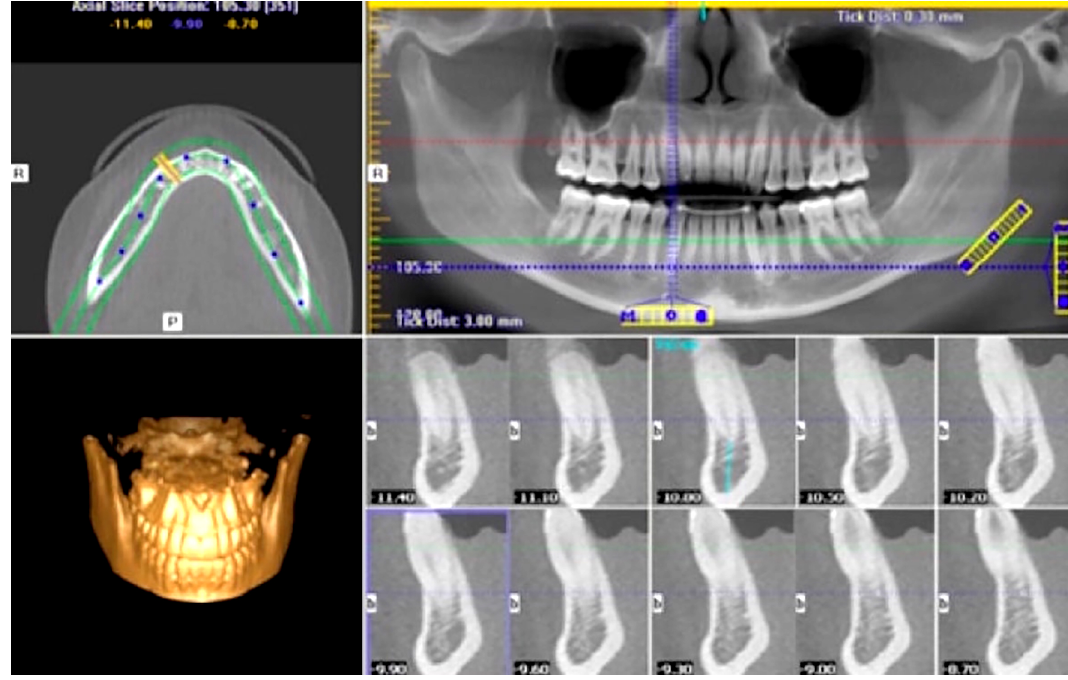
Figure 1- Axial, panoramic and parasagittal reformations and 3D reconstructions on i-CAT Vision ® software screen